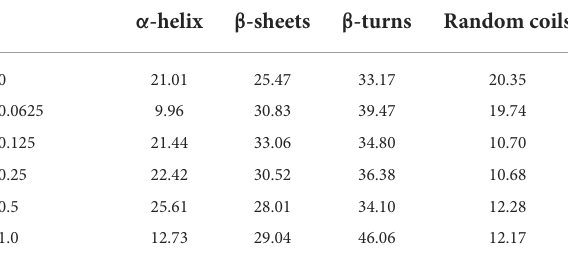
TABLE 2 The contents of secondary structure of E. coli treated by different concentration of cinnamaldehyde.